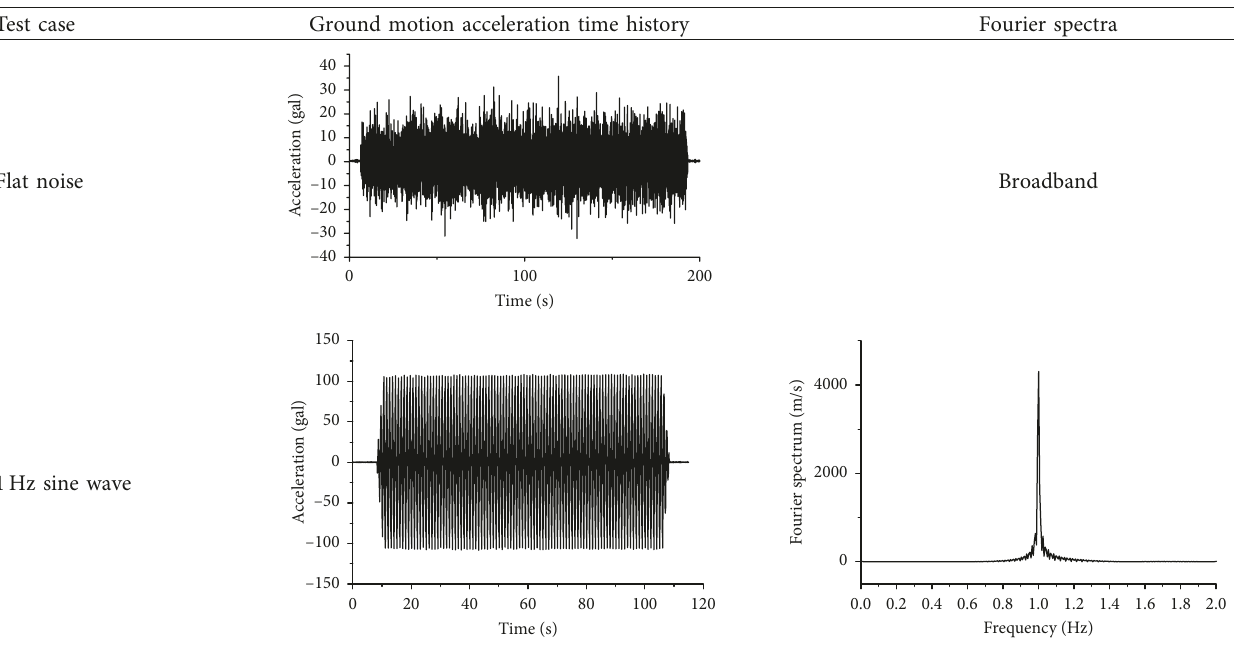
Figure 2: Test instrumentation and layout of sensors. (a). The layout of the instrumentation. Three instruments with different lengths are placed on the shaking table. The red circles are the targets used for vision tracking by cameras on the outside of the shaking table. In the background, it is the controller of the shaking table. (b) Sensor layout. On the top of the pole, main sensors are placed on the plate, which are cameras, accelerators, GPS sensors, and gyros. Table 1: Test cases for the shaking table